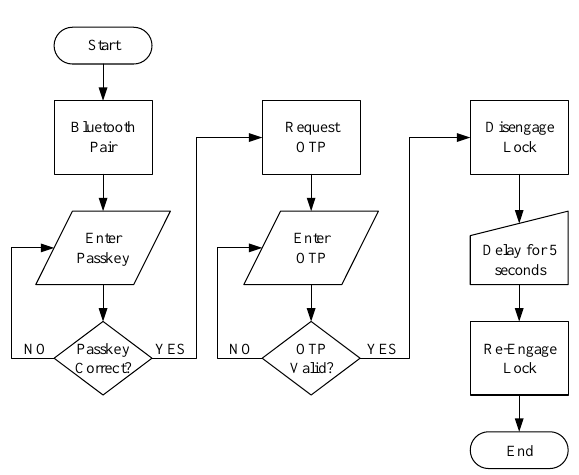
Fig. 10. Flow Diagram of the system implementation